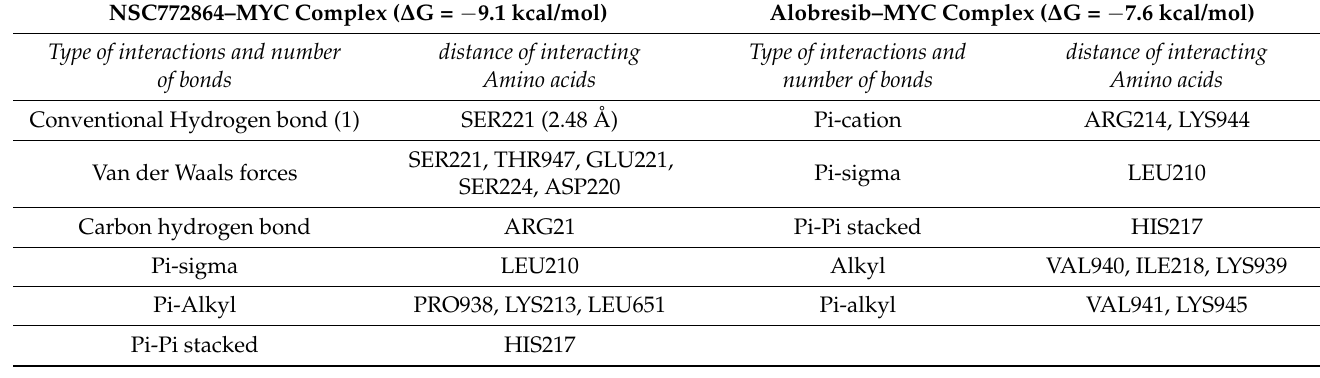
Table 5. NSC772864 and standard drug comparative docking profile against c-MYC.